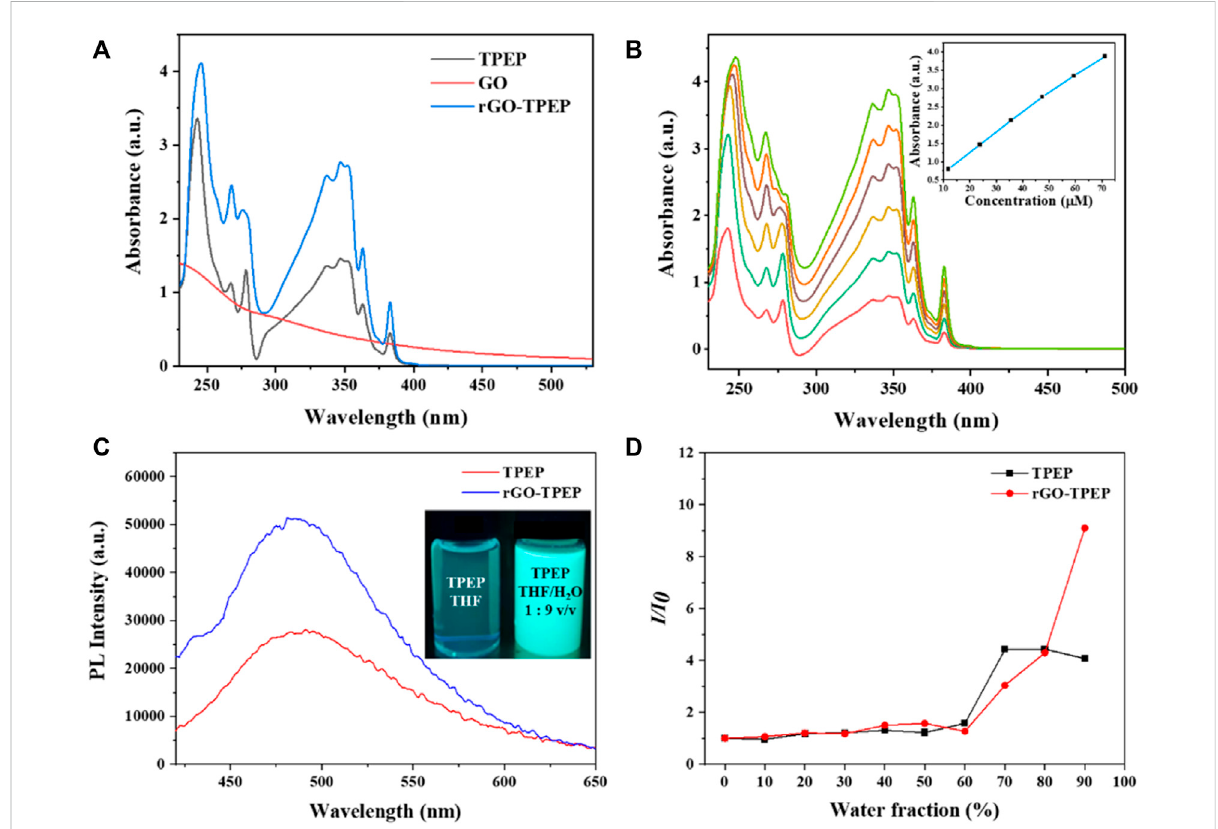
FIGURE 3 (A) UV-vis spectra of GO, TPEP, and rGO-TPEP in THF. (B) UV-vis spectra of rGO-TPEP at different concentrations, and inset shows concentration – absorption (at 347 nm) linear relationship. (C) Fluorescence spectra of TPEP and rGO-TPEP in THF/H 2 O mixed solution